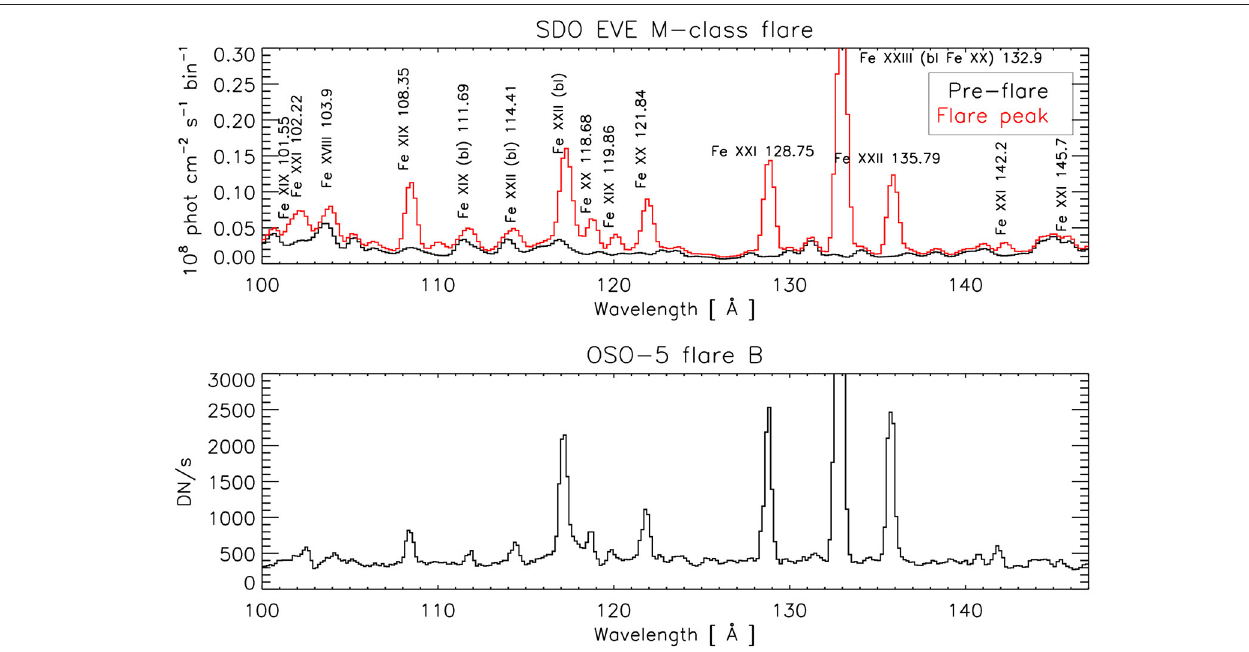
FIGURE 2 | SDO EVE SXR spectra of an M-class flare (top), and the OSO-5 flare B spectrum by Kastner et al. (1974). Note that the OSO-5 spectrum is uncalibrated.